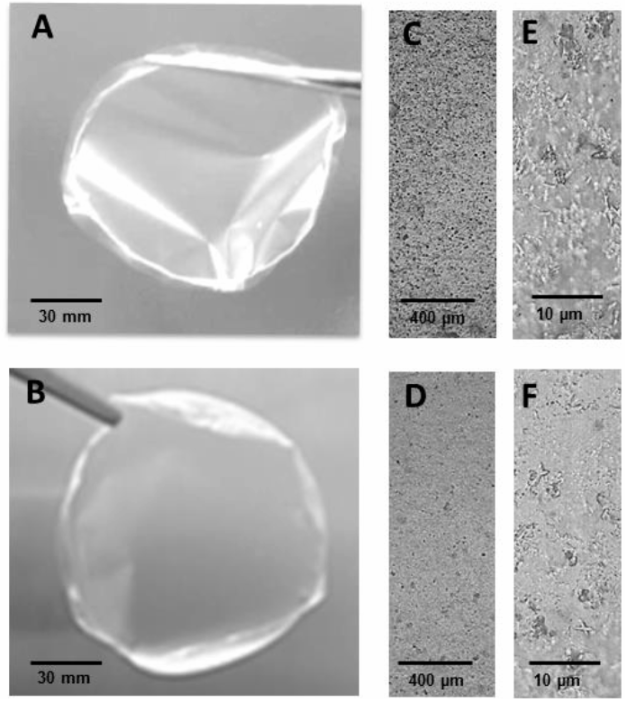
Figure 5. WEAX film ( A ) WEAX film entrapping D. hansenii ; ( B ) optical micrographs